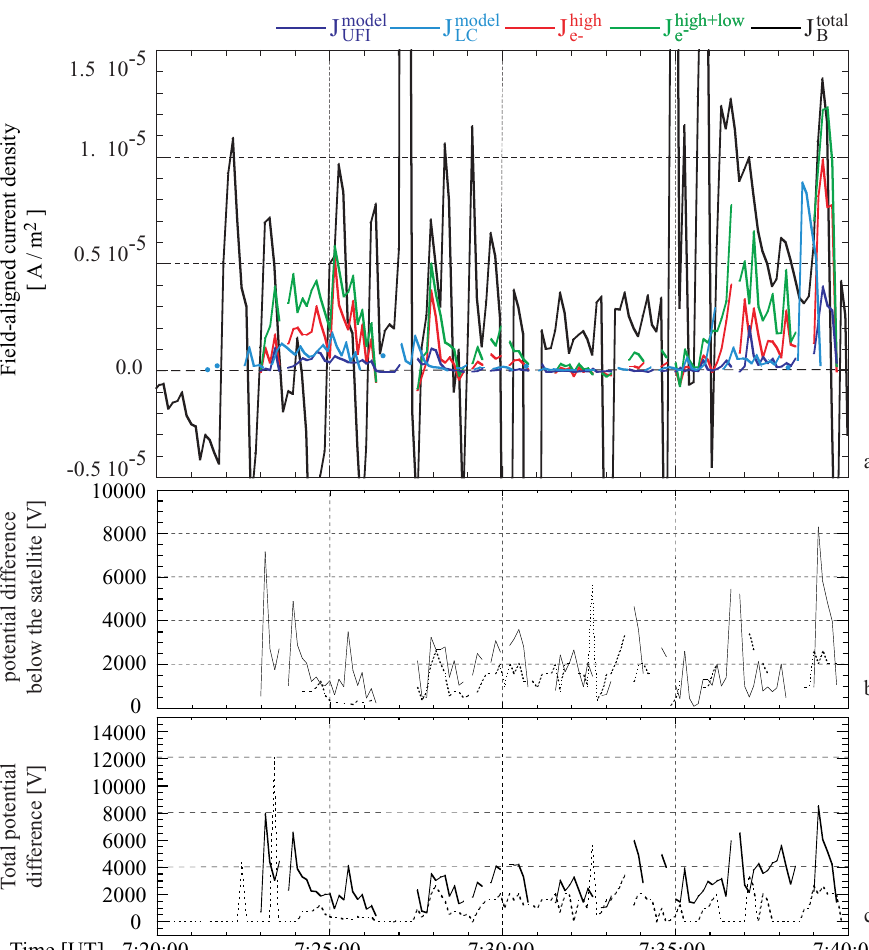
Fig. 4. (a) The field-aligned current densities estimated by the three different method (see the details in Sect. 2). J tot + low J high (green), J model (dark blue), and J model (light blue). φ b calculated and φ total (middle) using φ b in different estimation techniques LC UFI e − are displayed (b) and (c) . Solid lines indicate the data using φ LC , while dashed lines indicate the data using φ UFI b